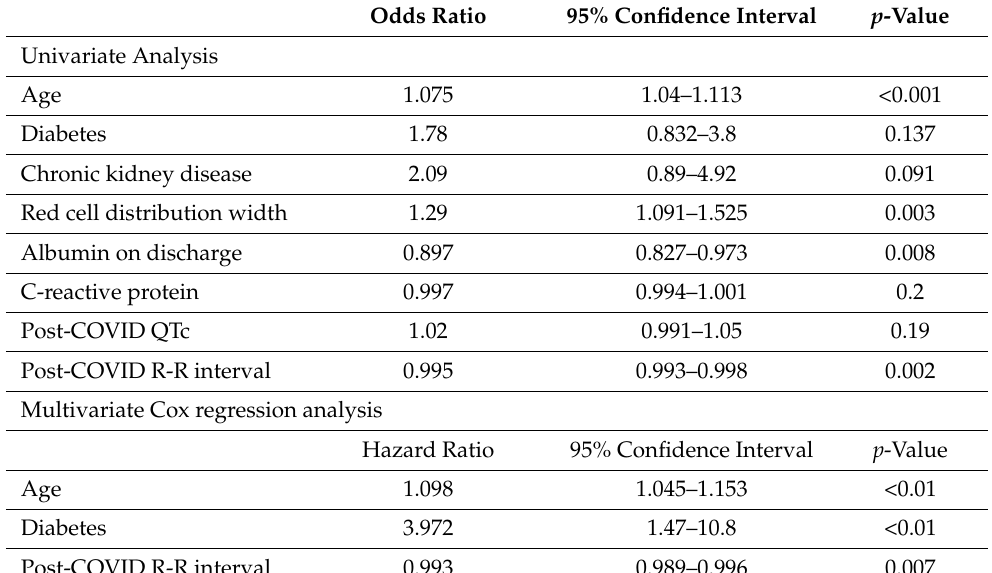
Table 3. Variates associated with mortality.